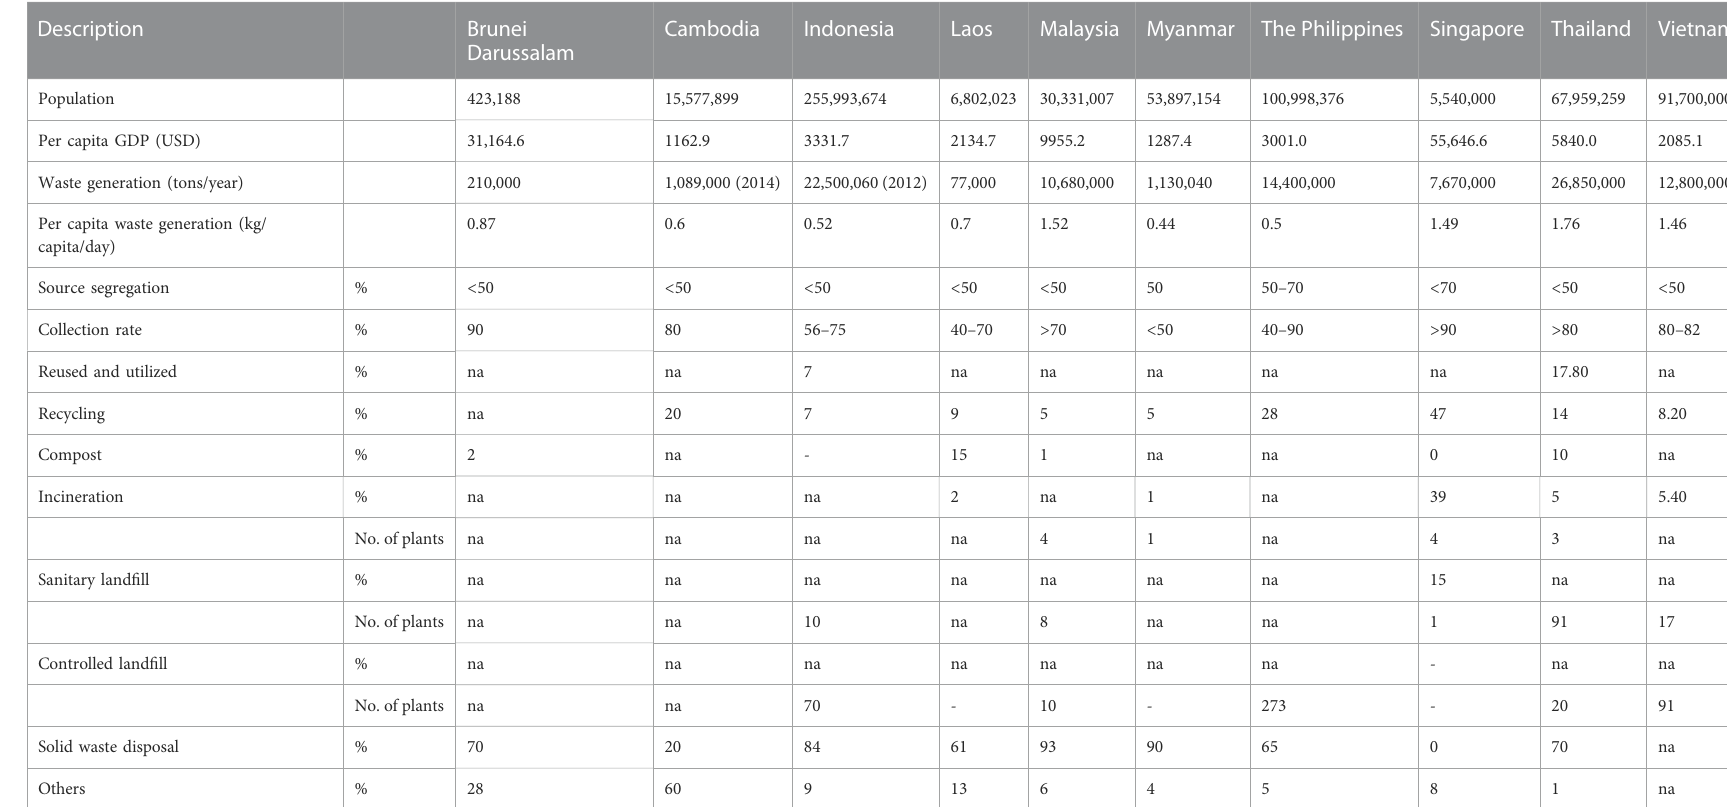
TABLE 1 Demographic context, waste generation, and waste management in Southeast Asian countries. Data extracted are based on 2015, unless speci fi ed Tun et al.